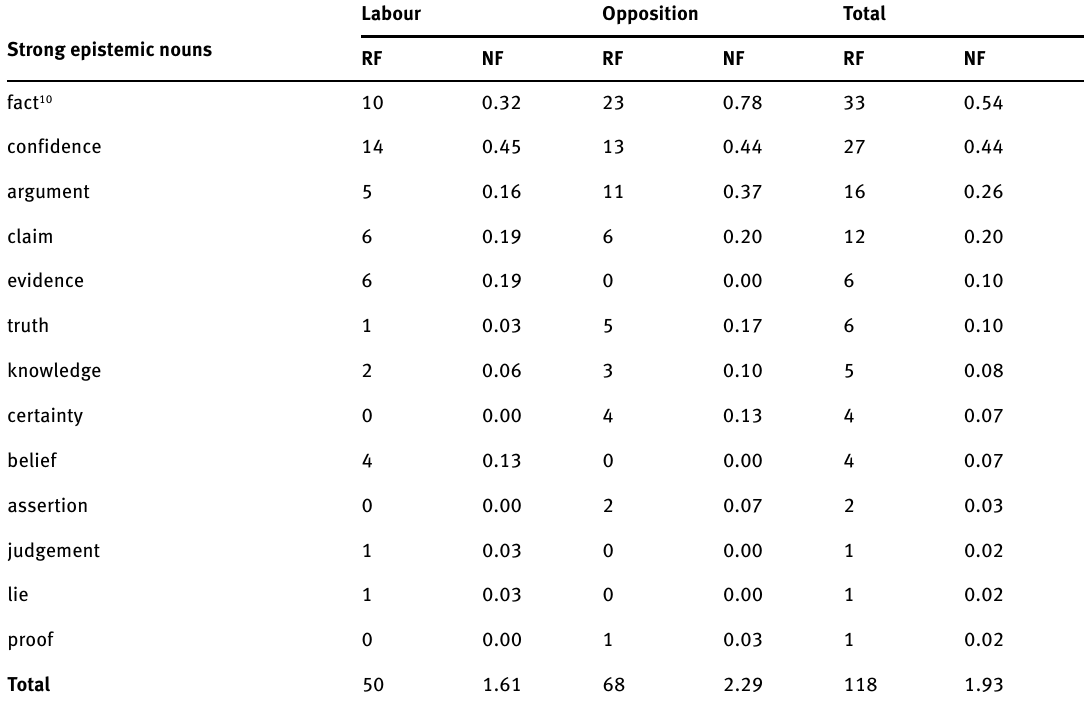
Table 6: Strong epistemic nouns.